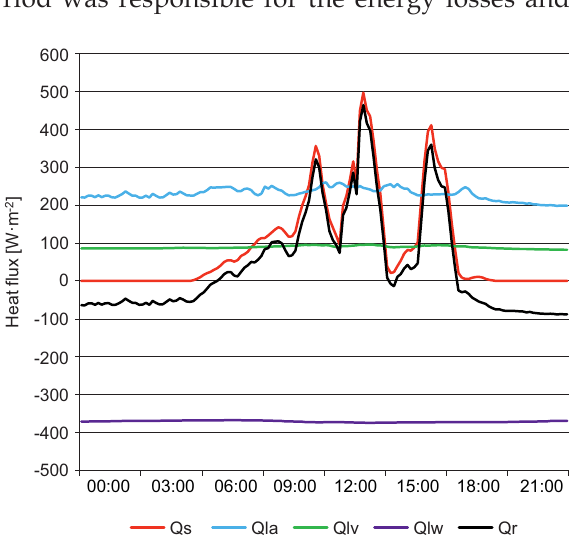
Fig. 2. Radiation components of the energy budget during Fig. 3. Radiation components of the energy budget during